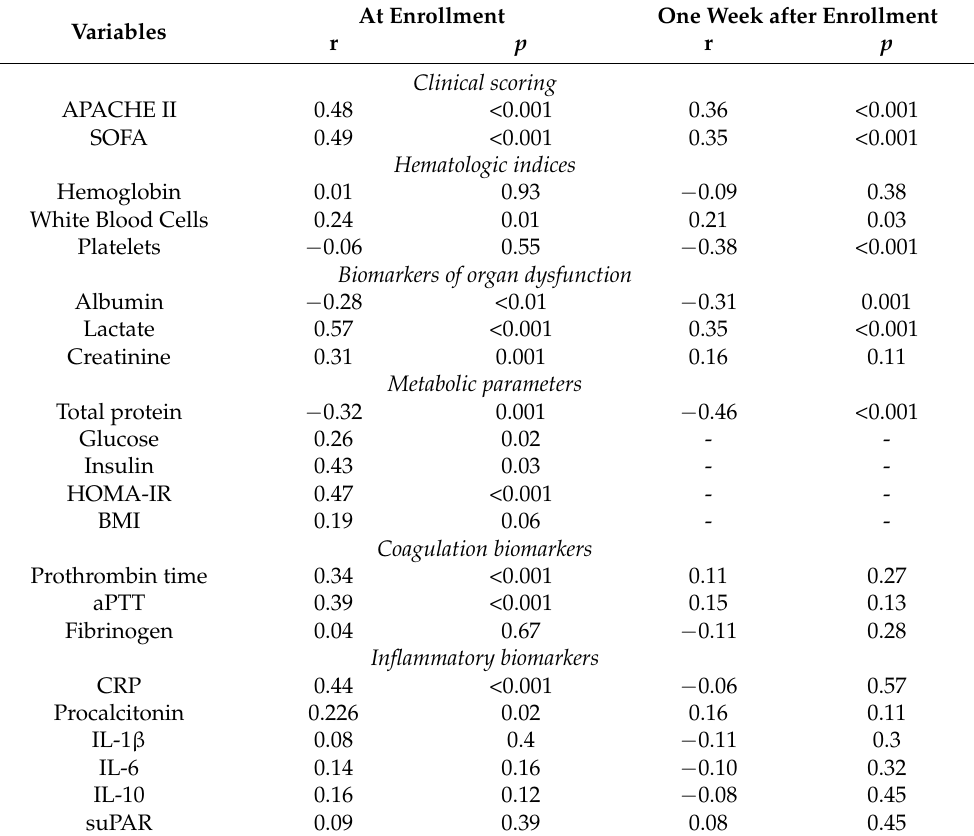
Table 5. Spearman correlation coefficients of circulating chemerin with severity scores and laboratory biomarkers in septic patients at enrollment and one week after ( n =